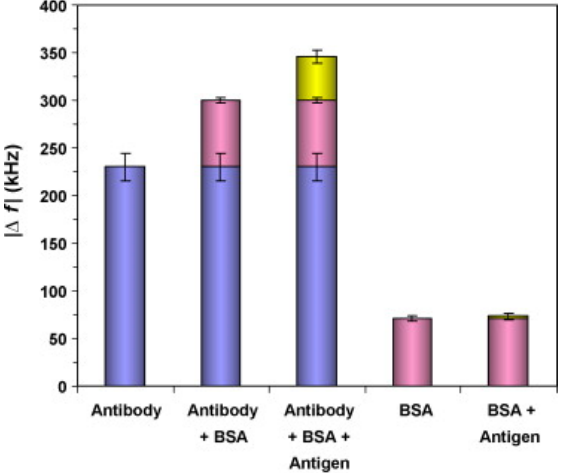
Figure 7. The frequency shift after h-PSA antibody adsorption (5 mg/L) for 15 min was 230 kHz (1st column), then BSA blocking (50 mg/L) for 25 min leads to 70 kHz shift (2nd column) and further antigen h-PSA binding (5 mg/L) for 15 min resulted another 46 kHz shift (3rd column). In control experiments, BSA adsorption at electrode surface (50 mg/L) for 30 min leads to 71 kHz shift (4th column) and then h-PSA antigen adsorption (5 mg/L) for 15 min over BSA resulted only 2 kHz shift (5th column), along y -axis Δ f represents resonant frequency shifts, adapted with permission from [161].